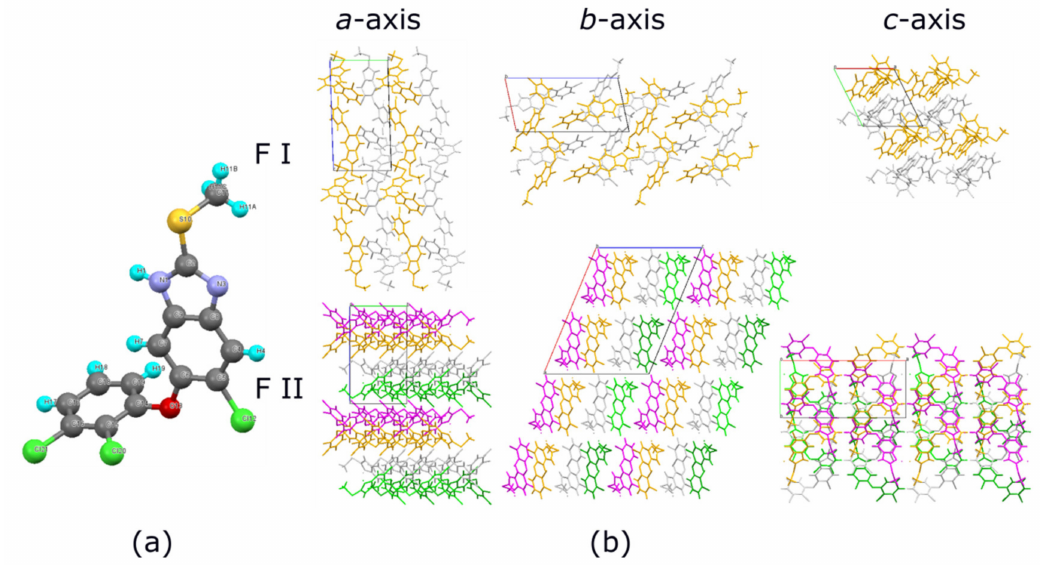
Figure 1. Crystal structures of a triclabendazole molecule. ( a ) Molecular structure of triclabendazole, where the cyan, gray, green, red, purple, and yellow-colored spheres represent H, C, Cl, O, N, and S atoms, respectively. ( b ) TCBZ crystal structures of forms I and II with molecular arrangements in the a -axis, b -axis, and c -axis, where molecules were colored by the operation of